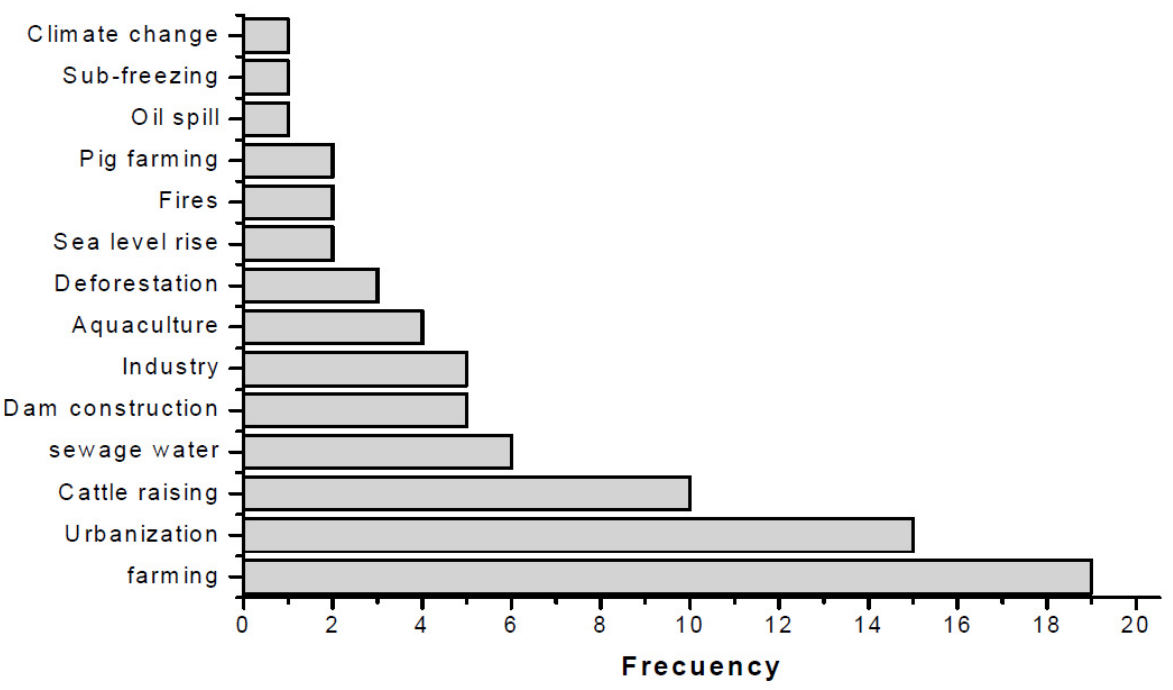
Figure 5. Frequency Distribution of Incident Factors affecting wetlands in America.